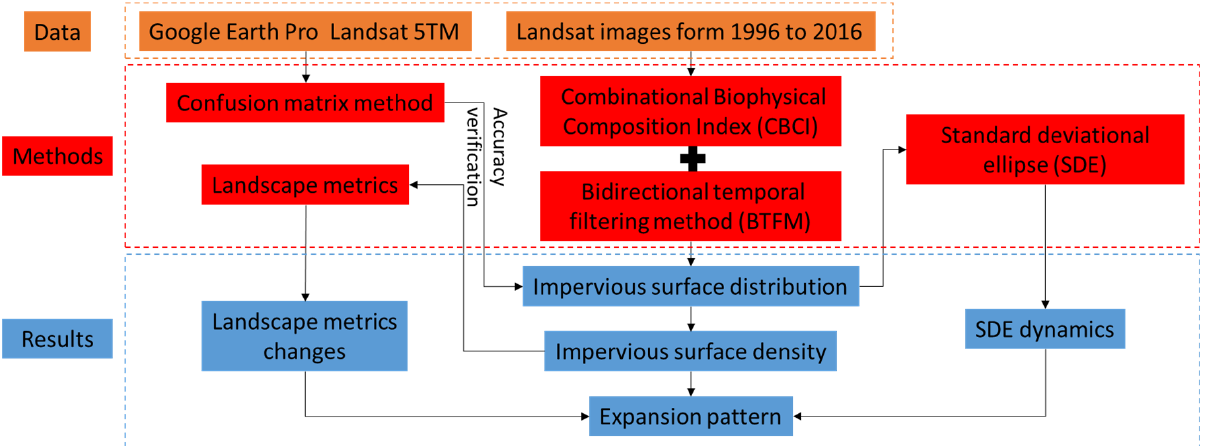
Figure 4. Flow chart for the current study.